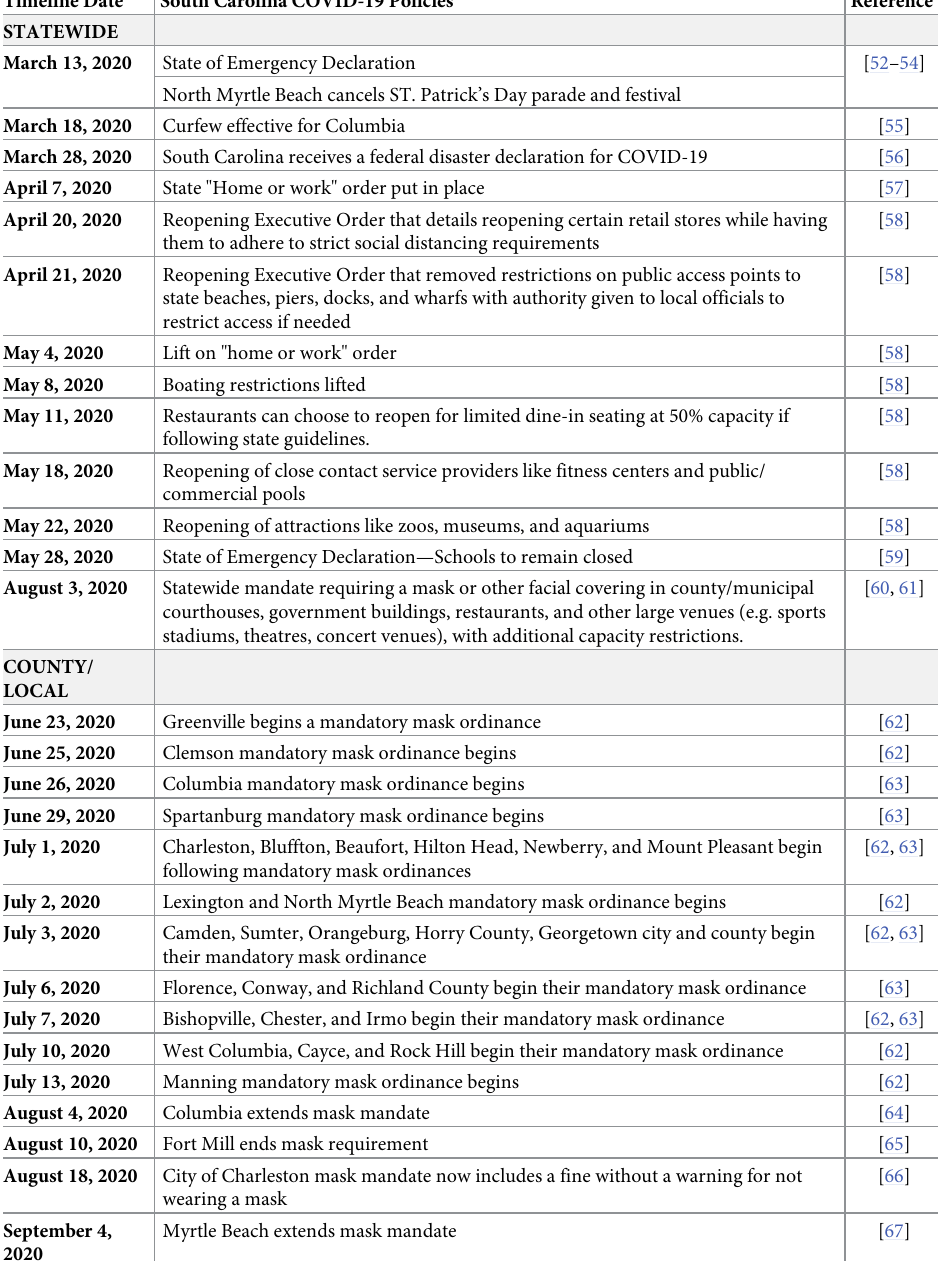
Table 1. South Carolina COVID-19 policies abbreviated